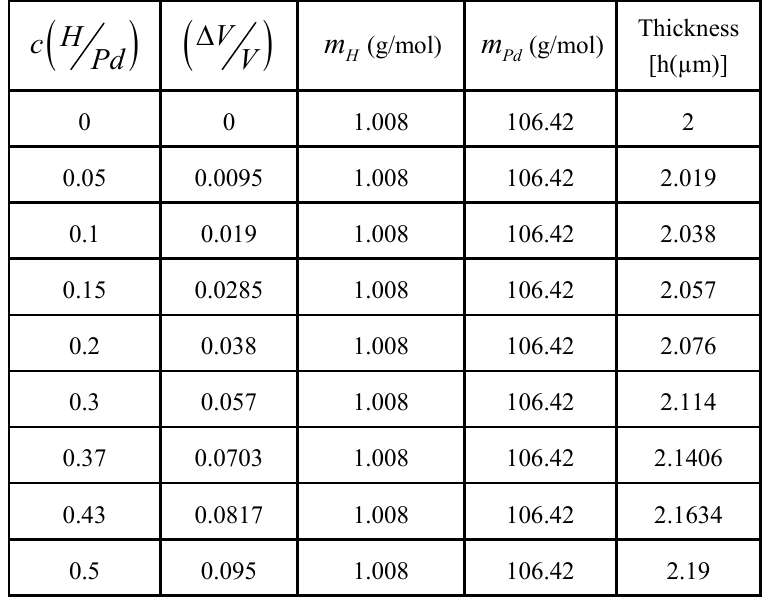
Table 5. Thickness values for the palladium film at different levels of hydrogen